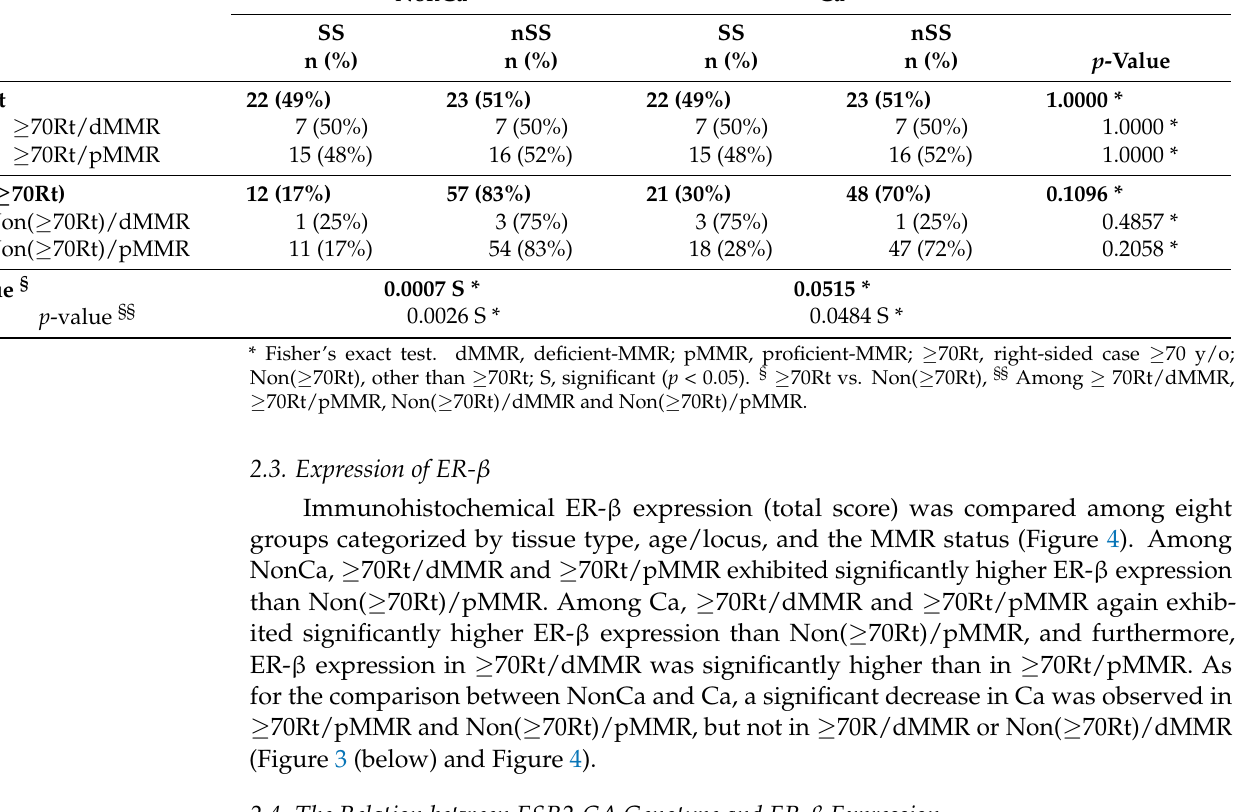
Table 2. ESR2 -CA repeat genotype category in non-cancerous (NonCa) or cancerous (Ca) tissue according to the patients’ age/locus and mismatch repair protein (MMR) status of tumors. ESR2 -CA Repeat Genotype Category NonCa